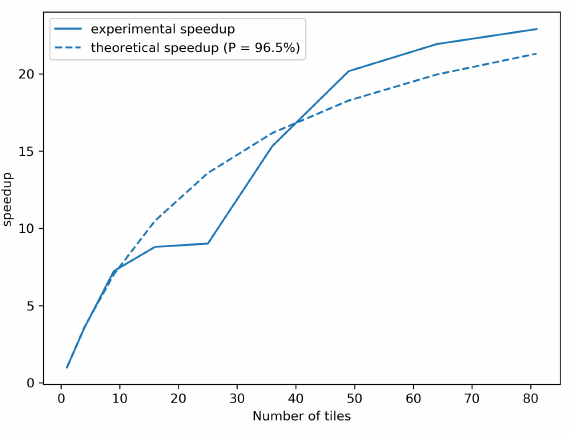
Figure 4. Experimental speedup via tiling (solid line) with theoretical speedup corresponding to Amdahl’s law (parallelization P = 95%, dashed